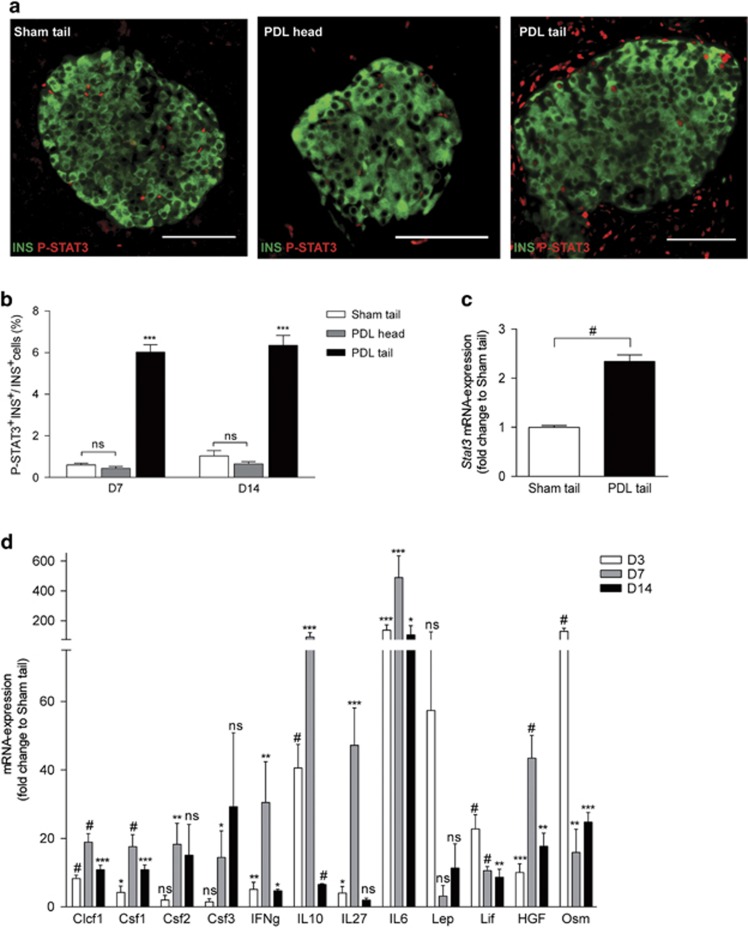
STAT3 expression and activity are stimulated in β-cells of PDL pancreas. (a) Immunostaining for phospho-STAT3 (Y705) (P-STAT3) and insulin in Sham tail, PDL head and PDL tail. (b) Quantification of data in a: percentage of P-STAT3+ INS+ cells at day 7 and 14 (D7 and D14) postsurgery (mean±S.E.M., n=3, ***P<0.001, ns: P>0.05, two-way ANOVA). (c) Stat3 mRNA in β-cells isolated at D7 from the tail of Sham- and PDL pancreas of MIP-RFP mice. Data are expressed as fold change versus Sham (=1) (n=3, #P<0.0001, Sham tail versus PDL tail by unpaired two-tailed t-test). (d) STAT3-activating factors whose expression increased 10-fold or more in PDL pancreas. Data represent the fold change in expression of each factor in PDL tail as compared with its expression in Sham tail (1) (D3: n=4, D7: n=4, D14: n=3, *P<0.05, **P<0.005, ***P<0.001, #P<0.0001, ns: P>0.05, Sham tail versus PDL tail by unpaired two-tailed t-test)